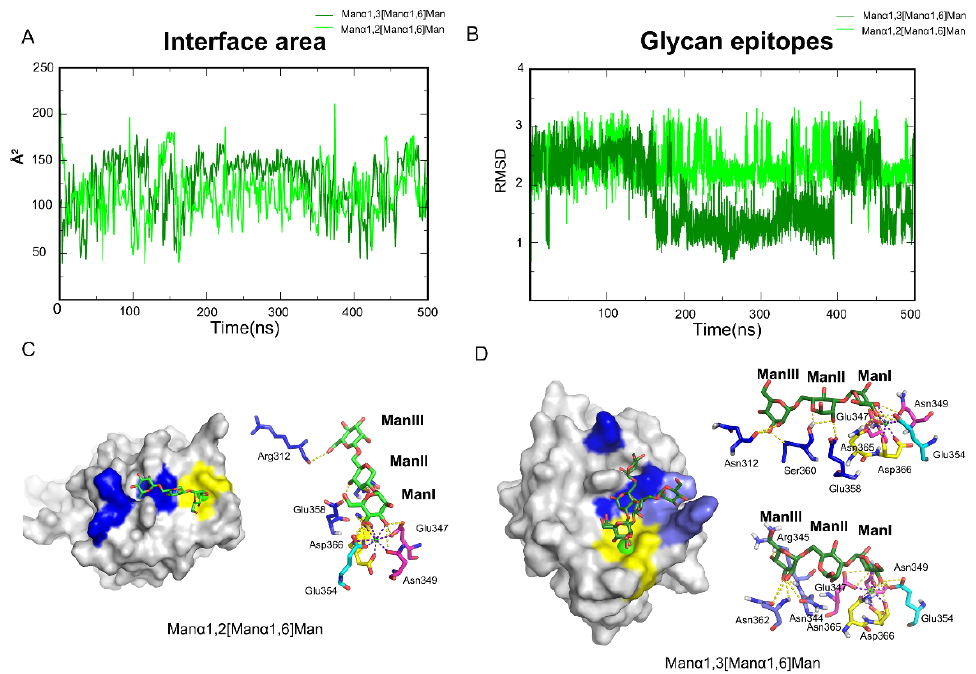
Figure 4. Aside from Core site, Rift and Valley sites on DC-SIGN that held Man α 1,2[Man α 1,6]Man and Man α 1,3[Man α 1,6]Man epitopes. ( A ) Interface area between two oligosaccharides and DC- SIGN along the trajectories. ( B ) RMSD of Man α 1,2[Man α 1,6]Man and Man α 1,3[Man α 1,6]Man along trajectories. ( C ) Man α 1,2[Man α 1,6]Man bind modes along the trajectory. EFS motif fixed Man α 1,2[Man α 1,6]Man through 3-OH and 4-OH in the ManII ring. ( D ) Two conformations of Man α 1,3[Man α 1,6]Man along the trajectory. EFS motif was consist of Glu358, Phe359, Ser360. Rift site is consist of Arg312, Phe313, Glu358. Valley is consist of Asn344, Arg345, Asn362. One in the Rift site, the other in the Valley. Core site is shown in yellow, Rift site is shown in blue; Valley is shown in purple-blue.